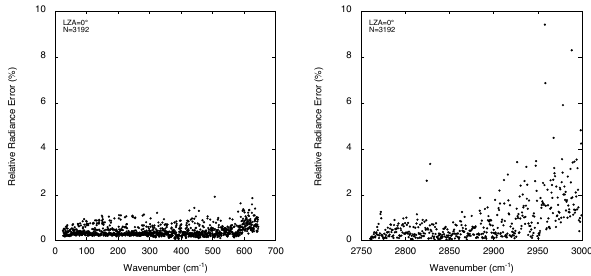
Figure 8. Locations of nearest nadir viewing SNOs, chosen as de- scribed in Sect. 2.4 between Metop-A and Terra (inner crosses) and Aqua (outer circles) for (a) the Arctic, and (b) Antarctic, for